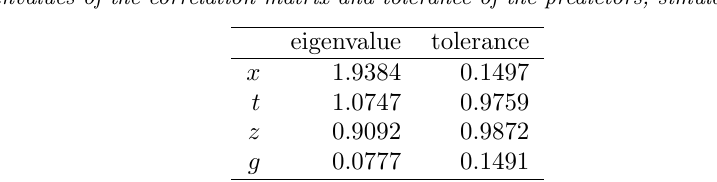
Eigenvalues of the correlation matrix and tolerance of the predictors, simulated